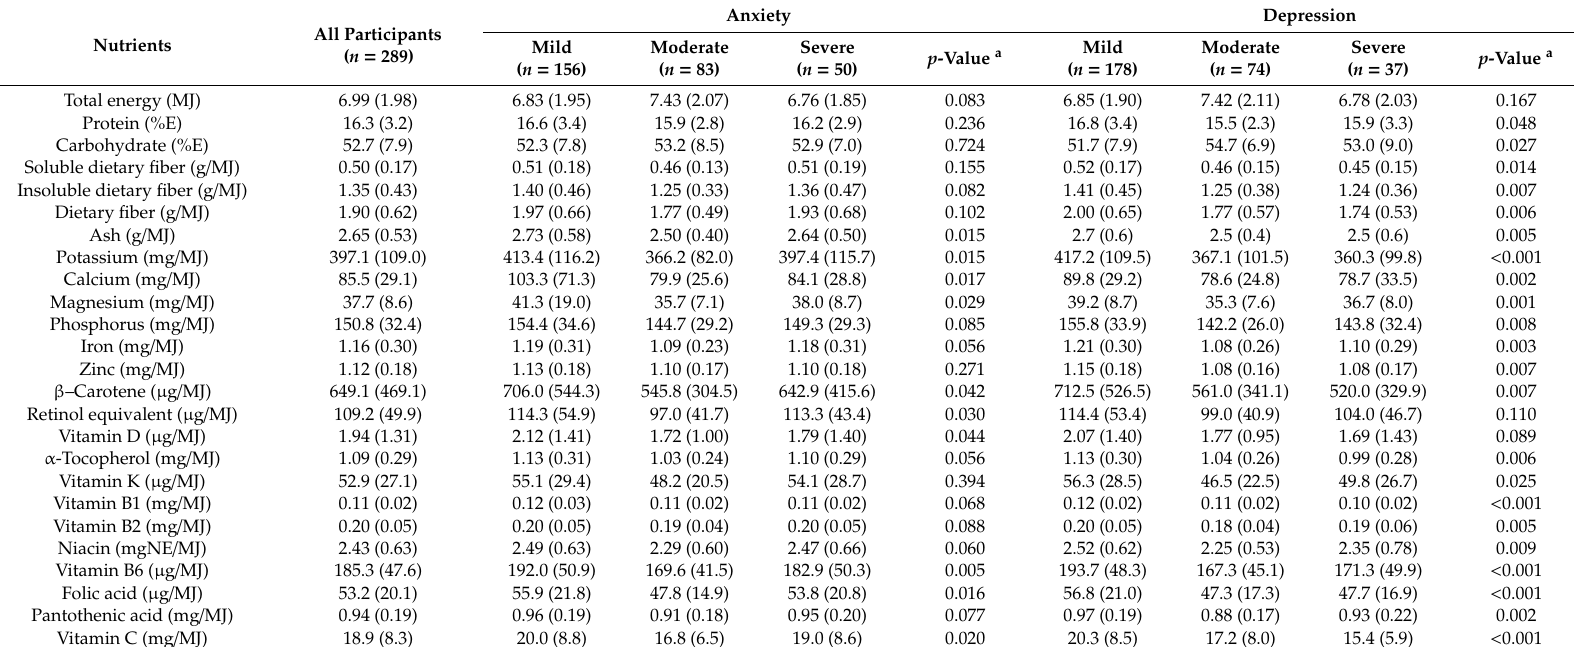
Table 3. The nutritional intakes that di ff ered significantly between the three anxiety / depression severity